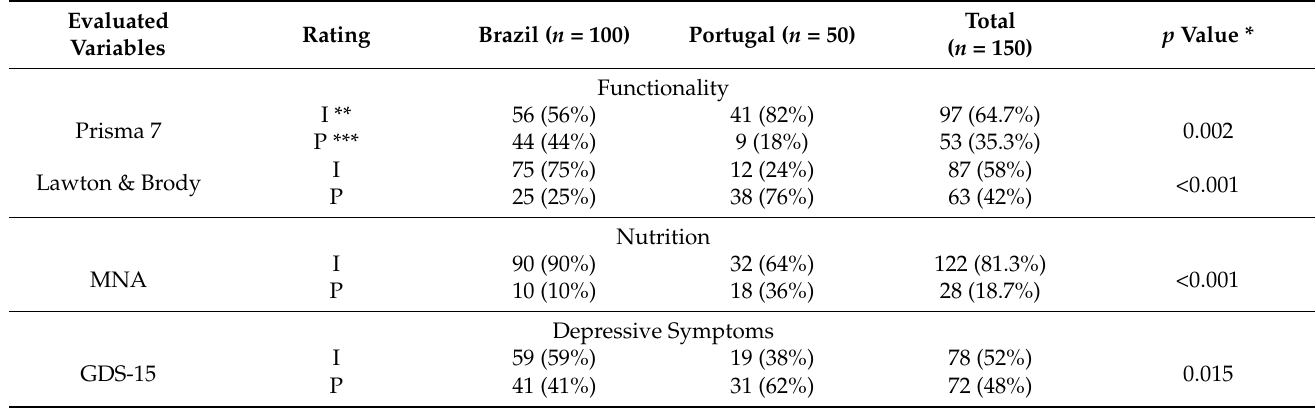
Table 3. Associations of the evaluated variables between Brazil and